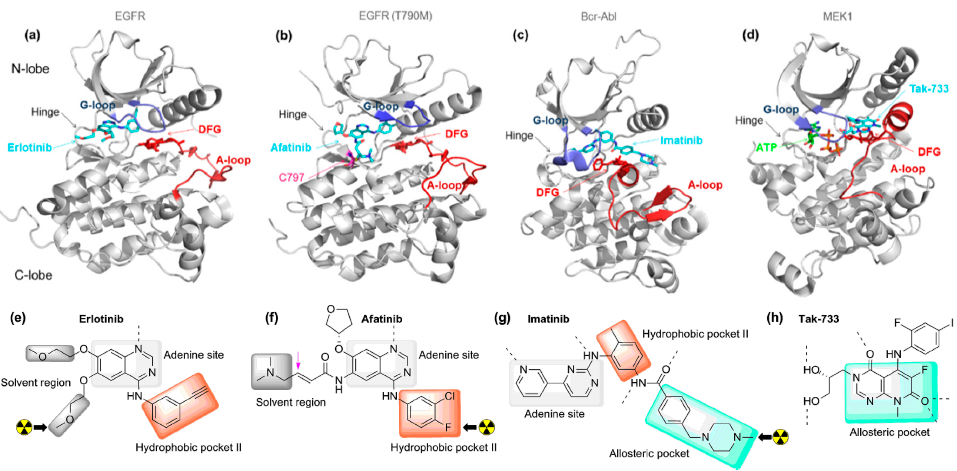
Figure 1. Representative examples of the primary types of small molecule kinase inhibitors including a DFG-in irreversible inhibitor. Kinases are shown in grey, the activation loops in burgundy, the glycine-rich loops in blue and the DFG motif in red (sticks). The carbon atoms of the inhibitors and the ATP are respectively represented in cyan and green ( a – c ); The chemical structures and schematic binding modes of the inhibitors are depicted. For inhibitors that have been radiolabeled for PET imaging, the position of the radionuclide (carbon-11 and fluorine-18) is indicated with a black arrow ( e – g ); ( a , e ) Type I inhibitor; co-crystal structure of erlotinib bound to epidermal growth factor receptor (EGFR) (DFG-in) (PDB ID: 1M17); ( b , f ) Type I inhibitor (irreversible); co-crystal structure of Afatinib bound to EGFR T790M (DFG-in) (PDB ID: 4G5P); ( c , g ) Type II inhibitor; co-crystal structure of imatinib bound to Bcr-Abl (DFG-out) (PDB ID: 1IEP); ( d , h ) Type III inhibitor; co-crystal structure of Tak-733 bound to MEK1 (DFG-in) (PDB ID: 3PP1).